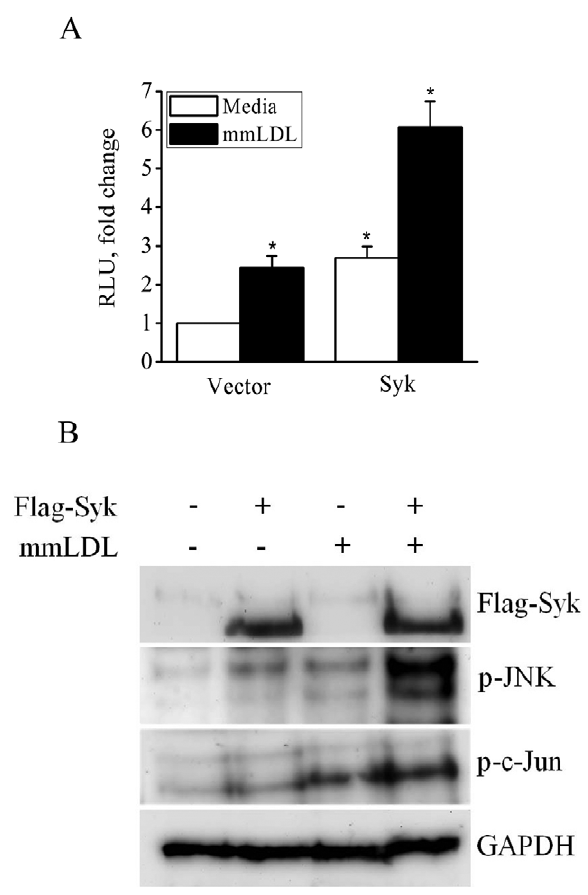
Figure 4. AP-1 activation in Syk-expressing CHO cells. ( A ) CHO cells were transfected with 1 m g Flag-Syk (or empty vector), 200 ng AP- 1-Luc reporter, and 200 ng b -galactosidase plasmid. After 36 hours, cells were incubated with media or mmLDL for 6 hours and luciferase activity was measured and normalized to b -galactosidase activity. Mean 6 SEM (n=3). *, p , 0.05 vector vs. Syk, and media vs. mmLDL. ( B ) CHO Cells were transfected with 300 ng empty vector or Flag-Syk. After 24 hours, cells were incubated with mmLDL for 6 hours and cell lysates were tested for expression of Syk (Flag) and for p-JNK, p-c-Jun and GAPDH.